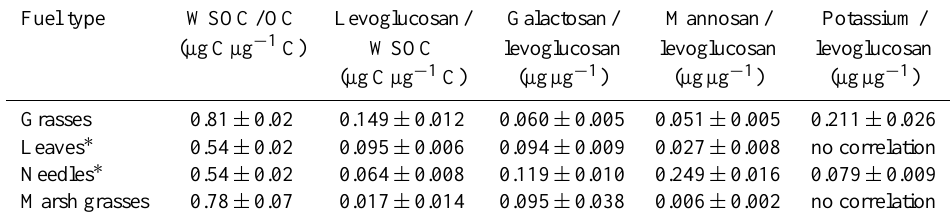
Table 2. WSOC to OC, levoglucosan to WSOC on a carbon mass basis, galactosan to levoglucosan, mannosan to levoglucosan, and potassium to levoglucosan ratios from controlled laboratory burns. Ratios were determined as the slope of a linear regression between the two species using data from the Fire Lab at Missoula Experiments (FLAME) (Sullivan et al., 2014).